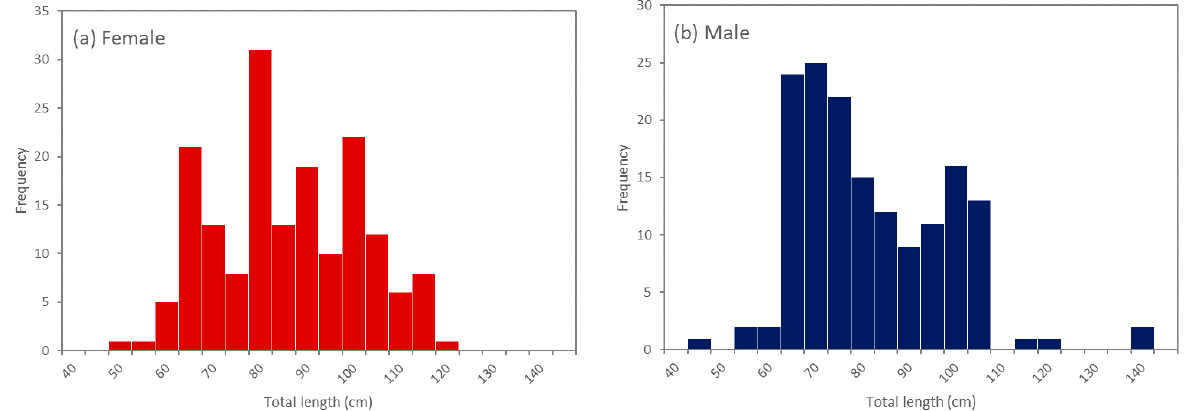
Figure 3. Total length frequency distribution of the spot-tail shark used in this study.